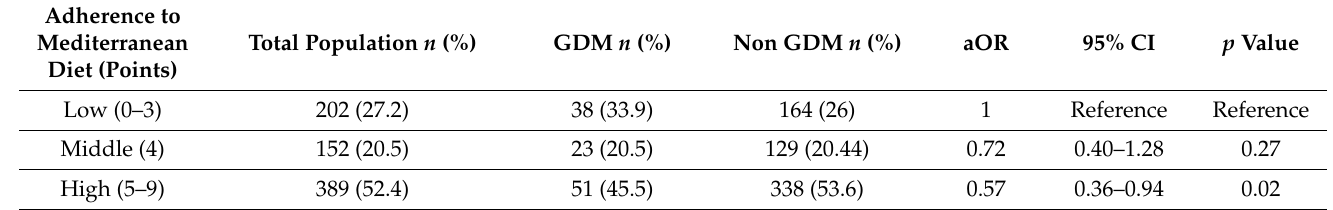
Table 4. Level of adherence to MDS, in total and by GDM status and likelihood of GDM by level of MDS adherence, using multiple logistic regression analysis.